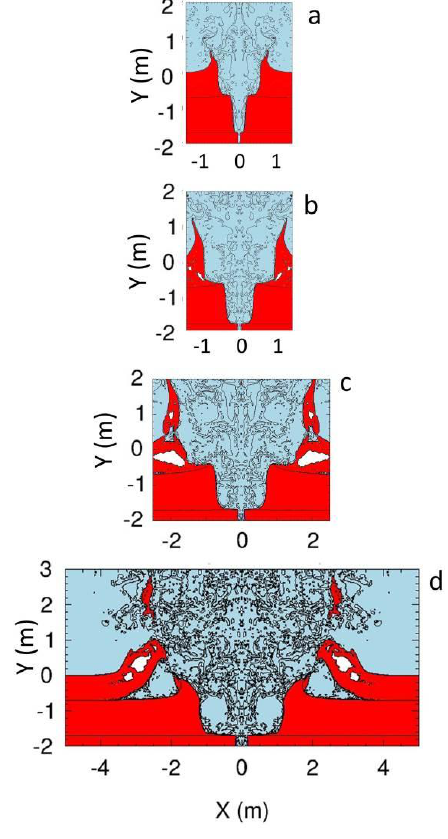
Figure 2. Representative density maps are shown for times when radial expansion of the channel in the clay-sand layer is approaching its maximum: ( a ) 9 MJ/m at t = 20 ms, ( b ) 27 MJ/m at t = 25 ms, ( c ) 81 MJ/m at t = 40 ms, and ( d ) 243 MJ/m at t = 55 ms. The red material represents three layers separated by black lines. From the bottom up, the layers are 0.3 m of granite, 1.0 m of clay-sand, and 0.7 m of peat with initial density of 1.12 × 10 3 kg/m 3 . The blue area is atmospheric air. The white spaces are voids at shear planes. Movies of pressure, density, and temperature are available online (accessed on 14 February 2021: https://datadryad.org/stash/share/Lt7dMvxEAUWNnkfKt2xPg2l5TuWz7Bbec67iY4Kvazg.